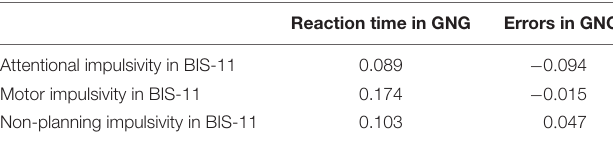
TABLE 4 | Pearson correlation coefficients for impulsivity and cognitive response